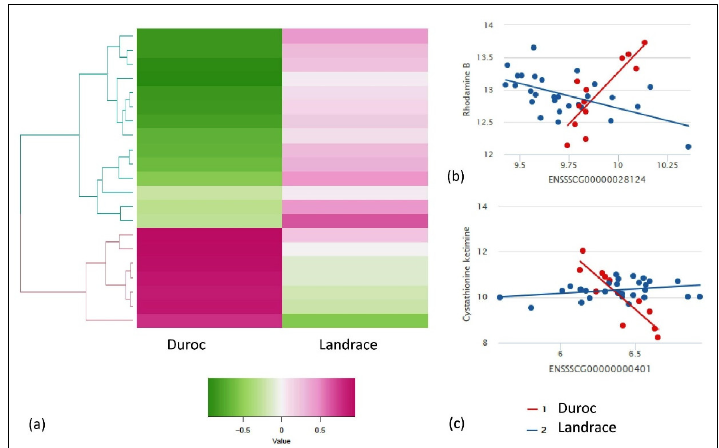
Figure 2. Results of IntLIM applied to breed-specific groups. ( a ) Clustering of 21 identified gene-metabolite pairs (FDR adjusted p -value of interaction coefficient < 0.1, Spearman correlation difference > 0.1 in Duroc and Landrace breeds, ( b ) Gene-metabolite difference in ENSSSCG00000028124 ( SNRPN )—rhodamine B (FDR adjusted p -value = 0.1, Duroc Spearman correlation = 0.7, Landrace Spearman correlation = −0.5), ( c ) Gene-metabolite difference in ENSSSCG00000000401 ( GLS2 )—cystathionine ketimine (FDR adjusted p -value = 0.01, Duroc Spearman correlation = −0.9, Landrace Spearman correlation = 0.2). Metabolites 2020 , 10 , 275